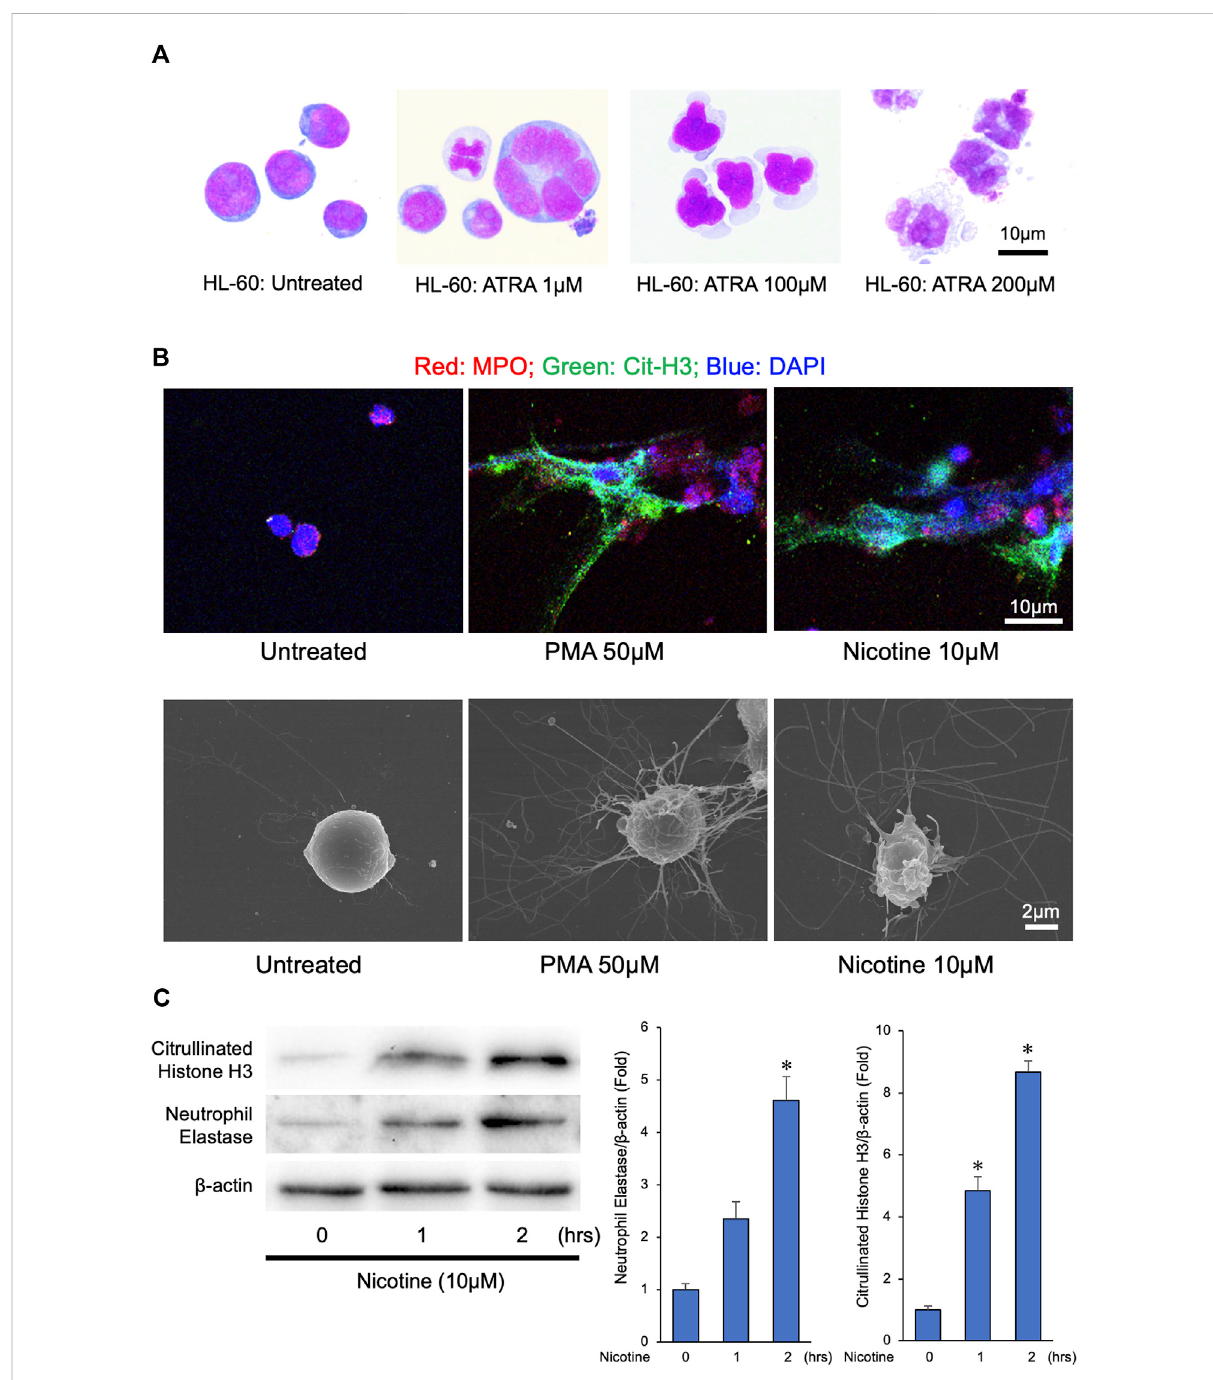
FIGURE 1 NETswerereleased fromdifferentiated HL-60 inresponseto phorbol 12-myristate13-acetate (PMA) ornicotine stimulation. (A) HumanHL-60 cells were differentiated into neutrophil-like cells by treating HL-60 cells with ATRA (200 µM) for 72 h (B) NETs were induced by PMA (50 µM) or nicotine (10 µM) administration to differentiated HL-60 cells. Upper panels: Representative confocal immuno fl uorescence images of differentiated HL-60 cells with or without PMA or nicotine administration stained for myeloperoxidase (MPO, red), citrullinated histone 3 (Cit-H3, green), and DNA (DAPI, blue). Lower panels: Representative scanned electron microscopic images of the differentiated HL-60 cells with or without the PMA or nicotine administration. (C) Left panel: Representative immunoblot imagesof neutrophil elastase, citrullinatedHistoneH 3 , and β -actin. Right panels : Densitometric analysis of immunoblots. * p < 0.05 vs. 0-h, n = 3 in each group. All data are expressed as mean ±